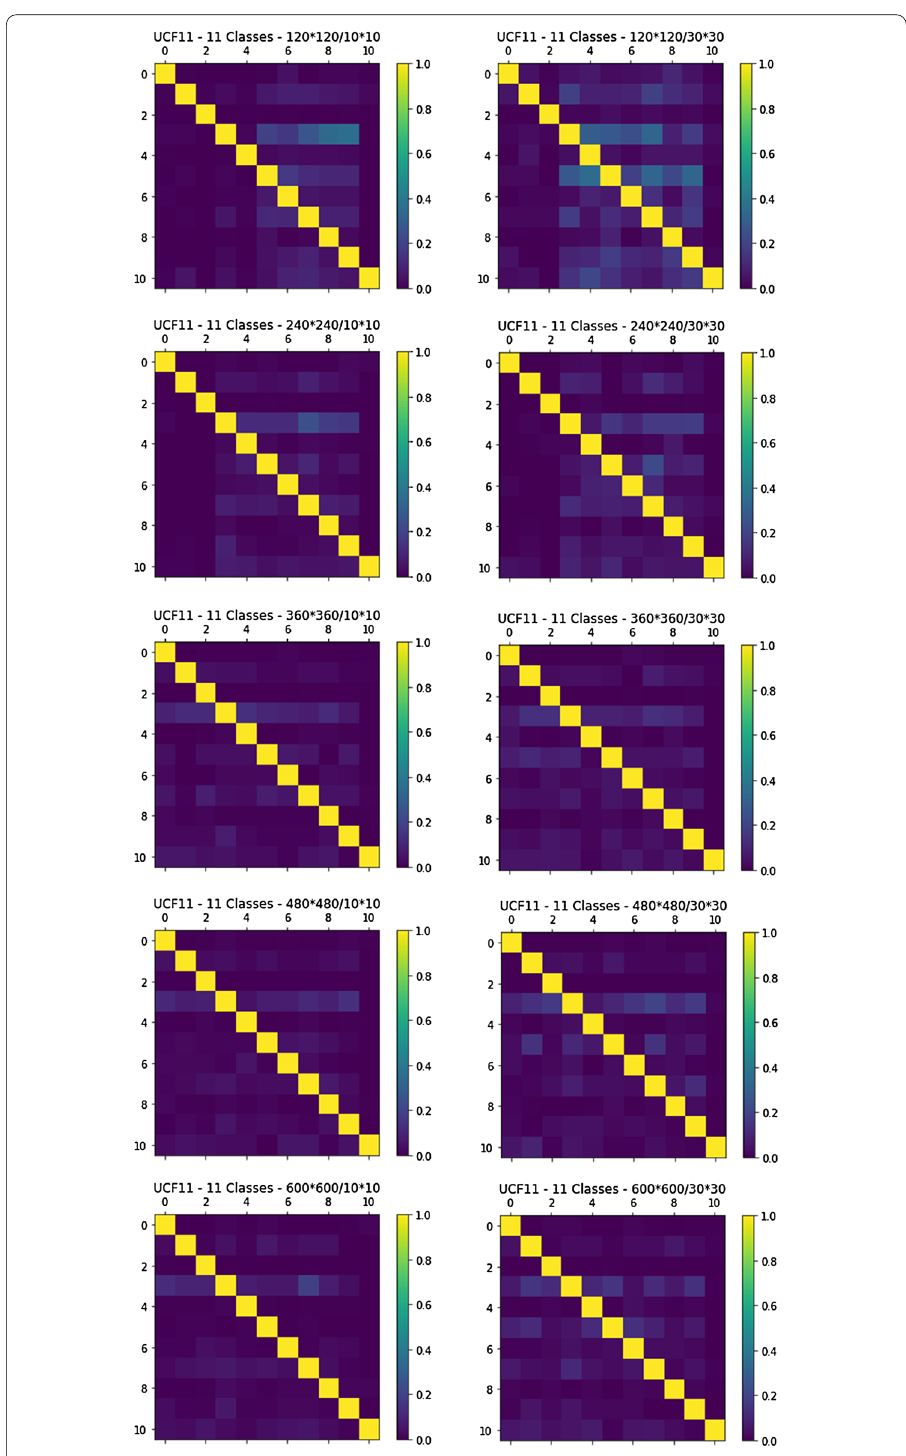
Fig. 11 Comparison of video classes’ accuracy—UCF11 (F‑size : 120*120 to 600*600, B‑size: 10 &